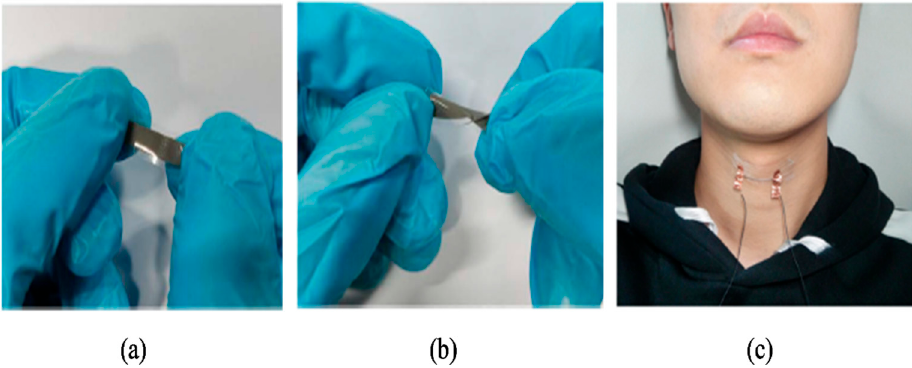
Figure 3. Images of AgNW composites to show ( a ) stretchability and ( b ) bendability. Reprinted with permission from Ref. [56]. Copyright 2020, Wiley Online Library. ( c ) Attachment of AgNW/PU strain sensor to the throat to sense strain. Reprinted with permission from Ref. [28]. Copyright 2019, American Chemical Society.